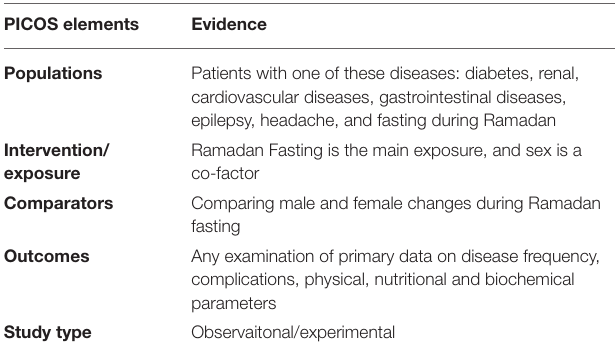
TABLE 1 | Populations, interventions, comparators, outcomes, and study type (PICOS)